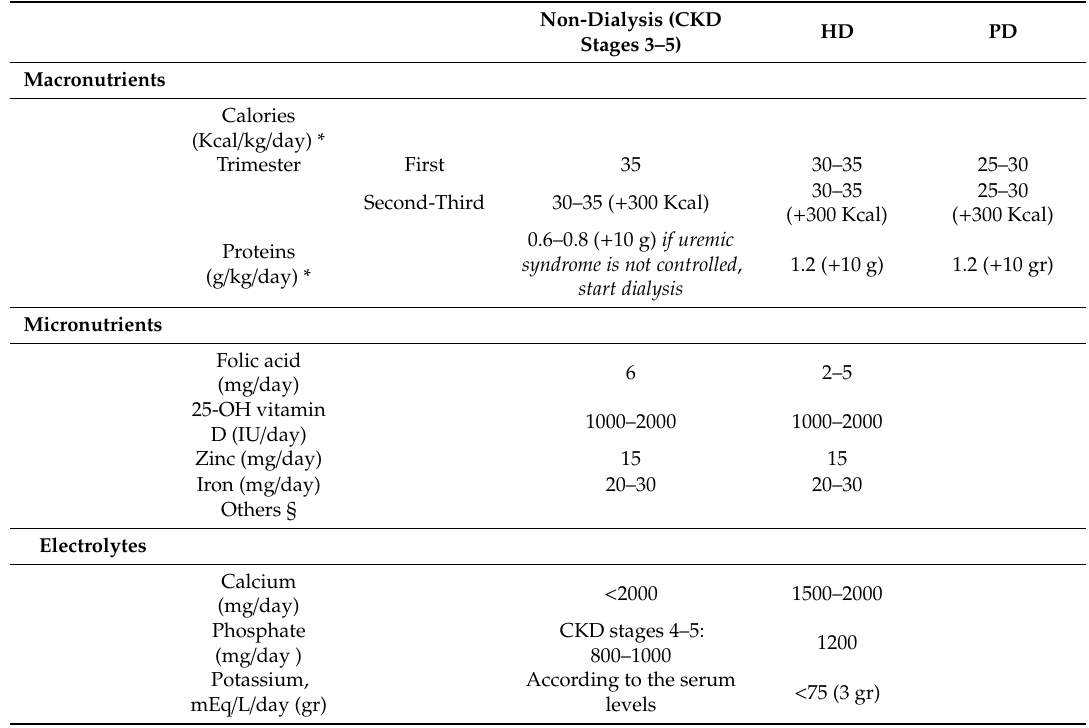
Table 1. Nutritional requirements in pregnant CKD